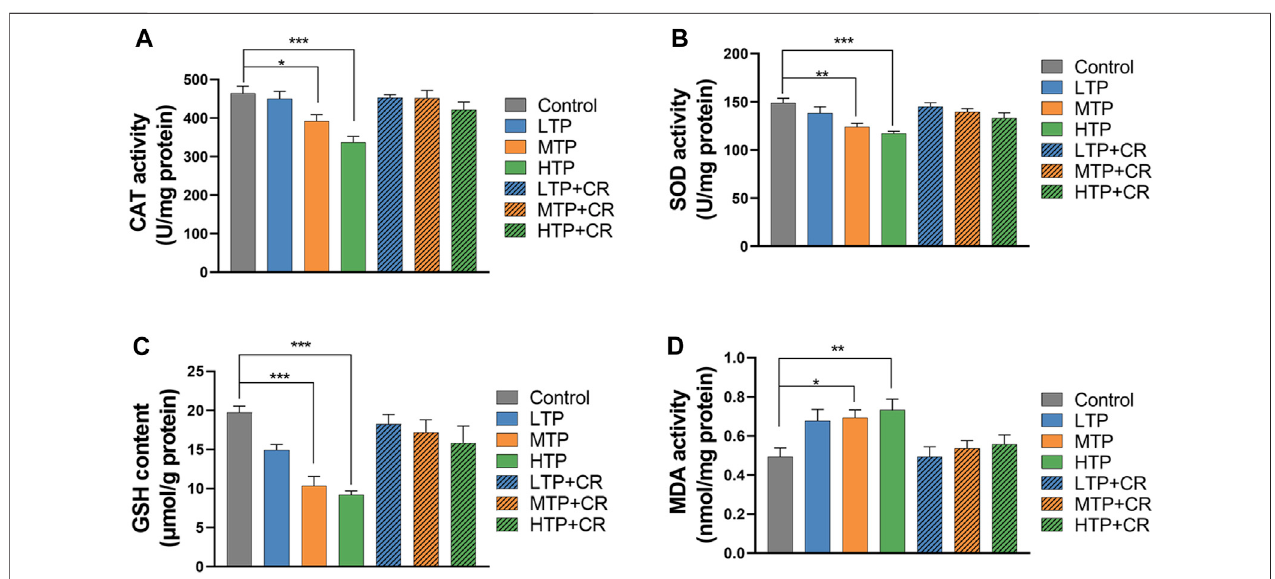
FIGURE 9 | Levels of CAT (A) , SOD (B) , GSH (C) , and MDA (D) in liver homogenates of mice (n = 6). * p < 0.05, ** p < 0.01, *** p < 0.001 vs Control.